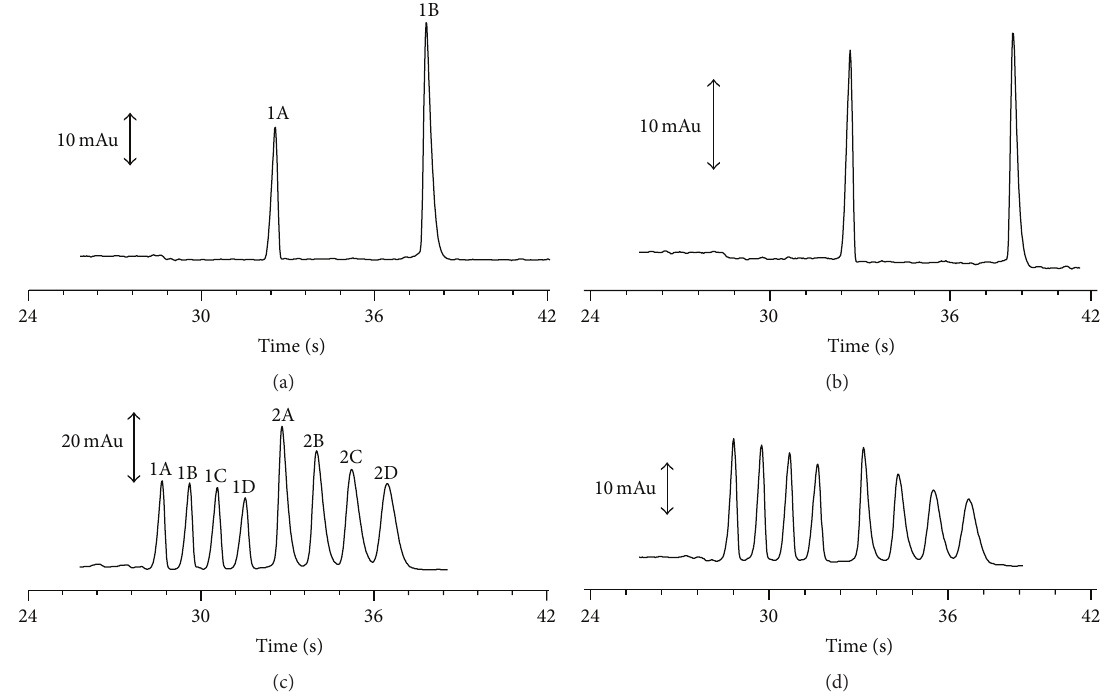
Figure 2: Comparison of single and multiple injections for standard solution ((a) and (c)) and a sample ((b) and (d)). Peaks: 1: benzylamine (IS); 2: lidocaine; A, B, C, and D represent the first, second, third, and fourth injection,